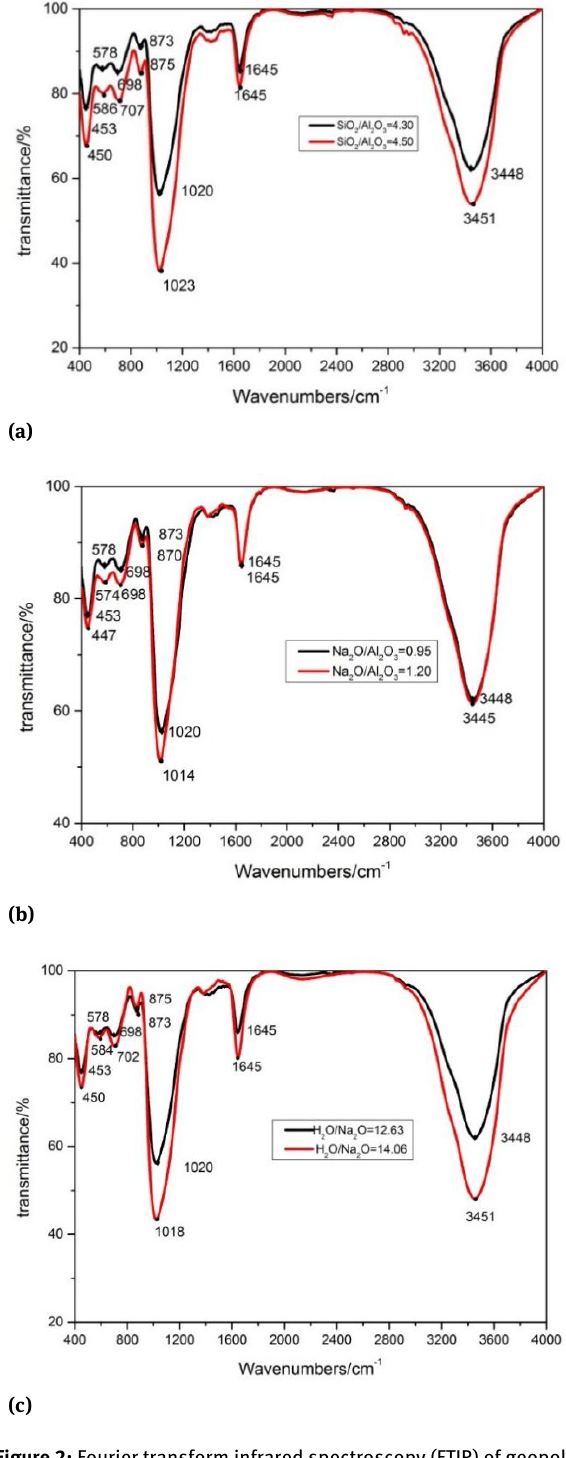
Figure 2: Fourier transform infrared spectroscopy (FTIR) of geopoly- mer (a) FTIR of S/A molar ratio of 4.30 and 4.50, (b) FTIR of N/A molar ratio of 0.95 and 1.20 and (c) FTIR of H/N molar ratio of 12.63 and